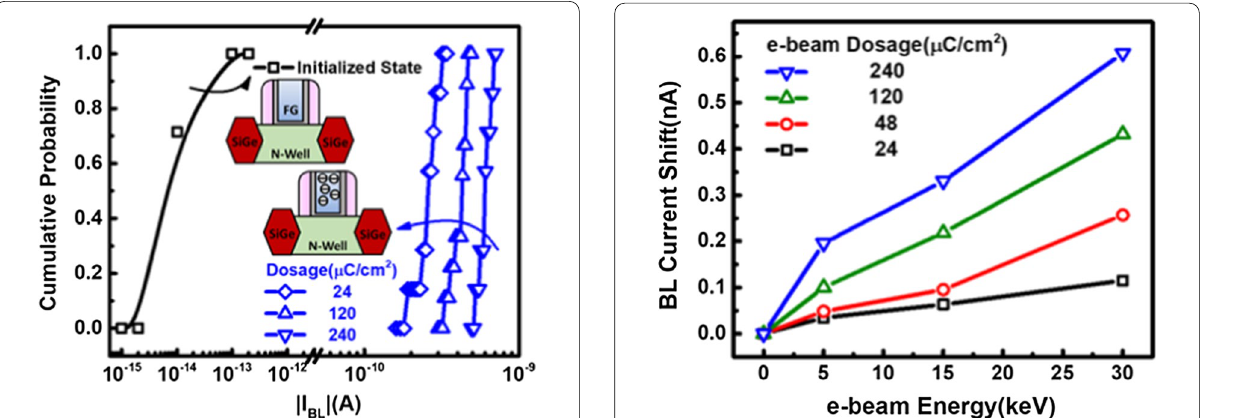
Fig. 6 The injected dosage and its accelerating energy can be precisely reflected by the resulting BL current of the e‑beam exposed